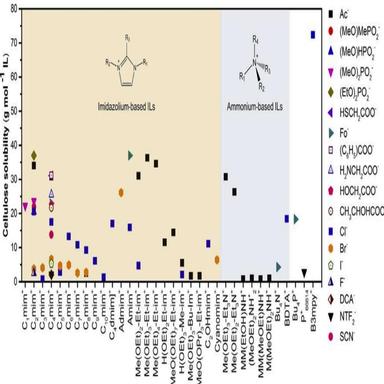
Cellulose solubility as a function of cation–anion pairing. Source: Reproduced, with permission, from Weldemhret et al. (2021). Copyright 2021, Elsevier. License number (5256861251904).